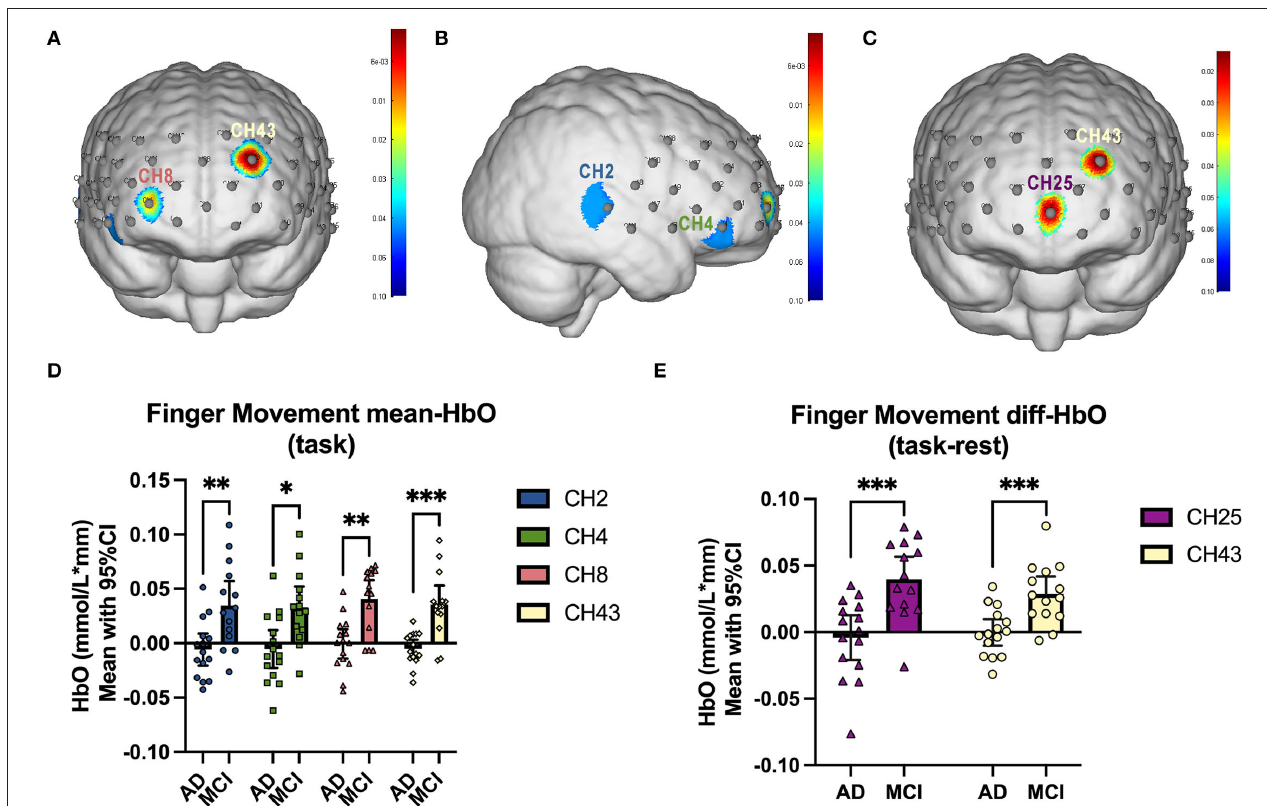
FIGURE 3 | fNIRS comparison between mAD and MCI subjects. (A,B) The front and right lateral view of significant channels in mean Oxy-Hb comparison, and the statistics were presented in (D) . (C) The front view of significant channels in diff-Oxy-Hb (task-rest) comparison, and the statistics were presented in (E) . * p < 0.05; ** p < 0.01; *** p <